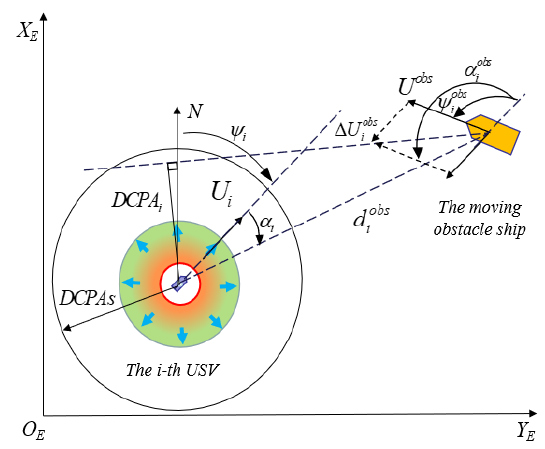
Figure 5. Illustration of encounter scenario.